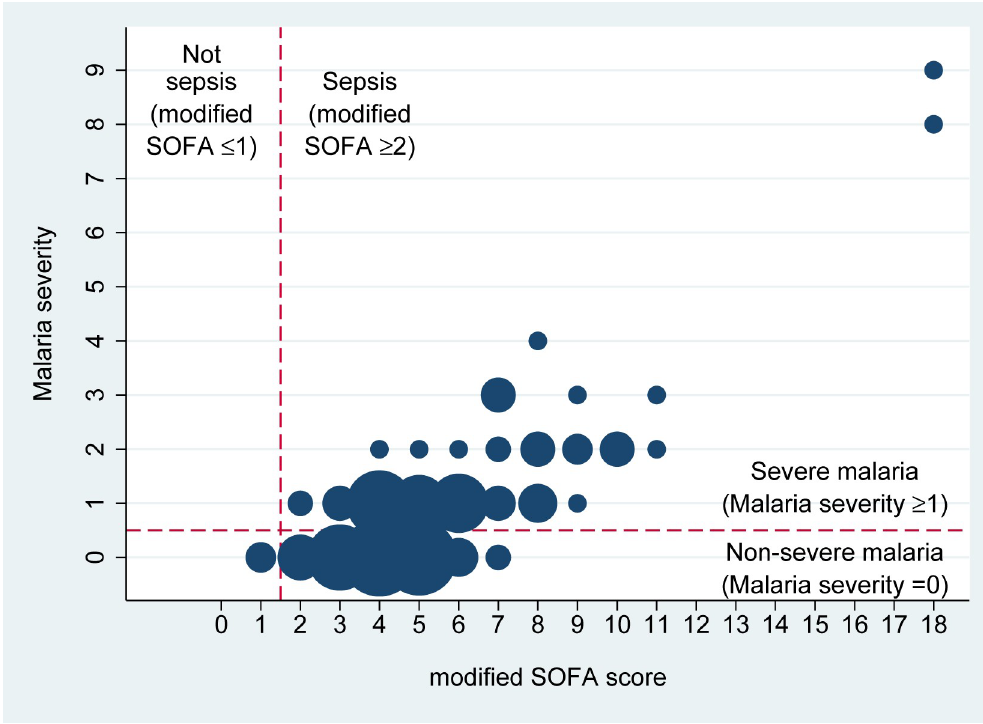
Fig 2. Relationship between modified SOFA score and malaria severity (the total number of WHO severity criteria for severe malaria satisfied by the patient). Size of each dot represents the total number of patients with a modified SOFA score and malaria severity. Each smallest dot represents one patient, and the biggest dot represents 21 patients (modified SOFA score of 4 and malaria severity of 0). Both fatal patients in the study had malaria severity of � 8.